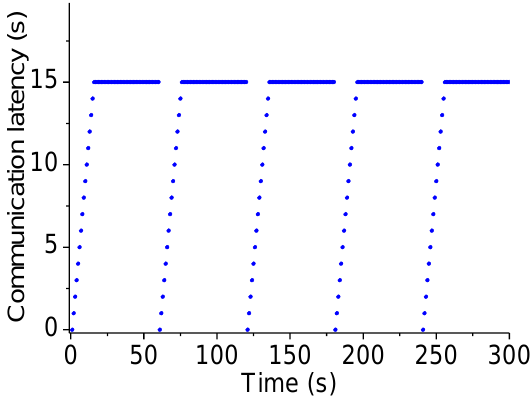
Figure 1. Simulated latency time for asynchronous real-time kinematic (ARTK)